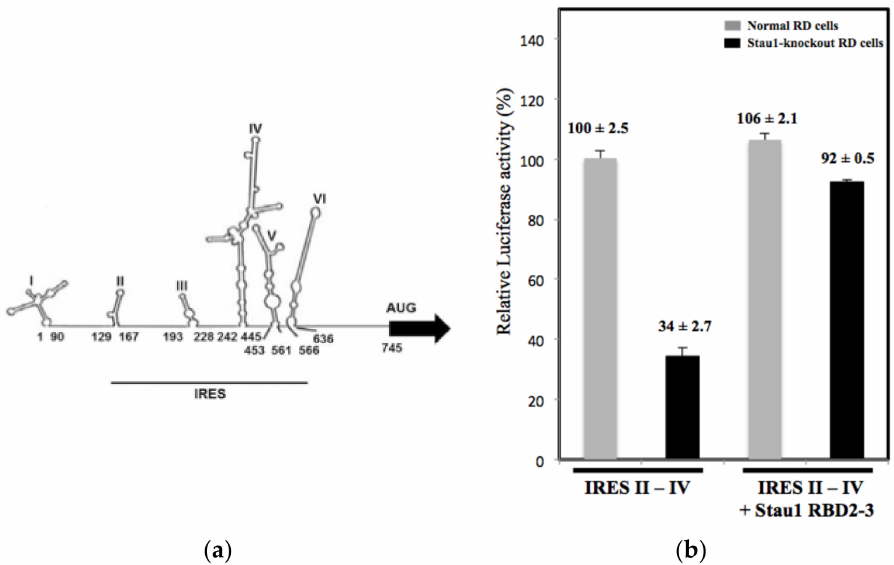
Figure 5. Stau1 positively regulates the EV-A71 IRES activity. ( A ) EV-A71 viral IRES genome structure. ( B ) The effect of Stau1 on the IRES activity was evaluated with IRES domain II–IV. The IRES domain II–IV was subcloned into pGL4.17 (containing Firefly luciferase gene) plasmid followed by cotransfection with pCDNA3.1-CMV (containing Renilla luciferase gene) in normal cells